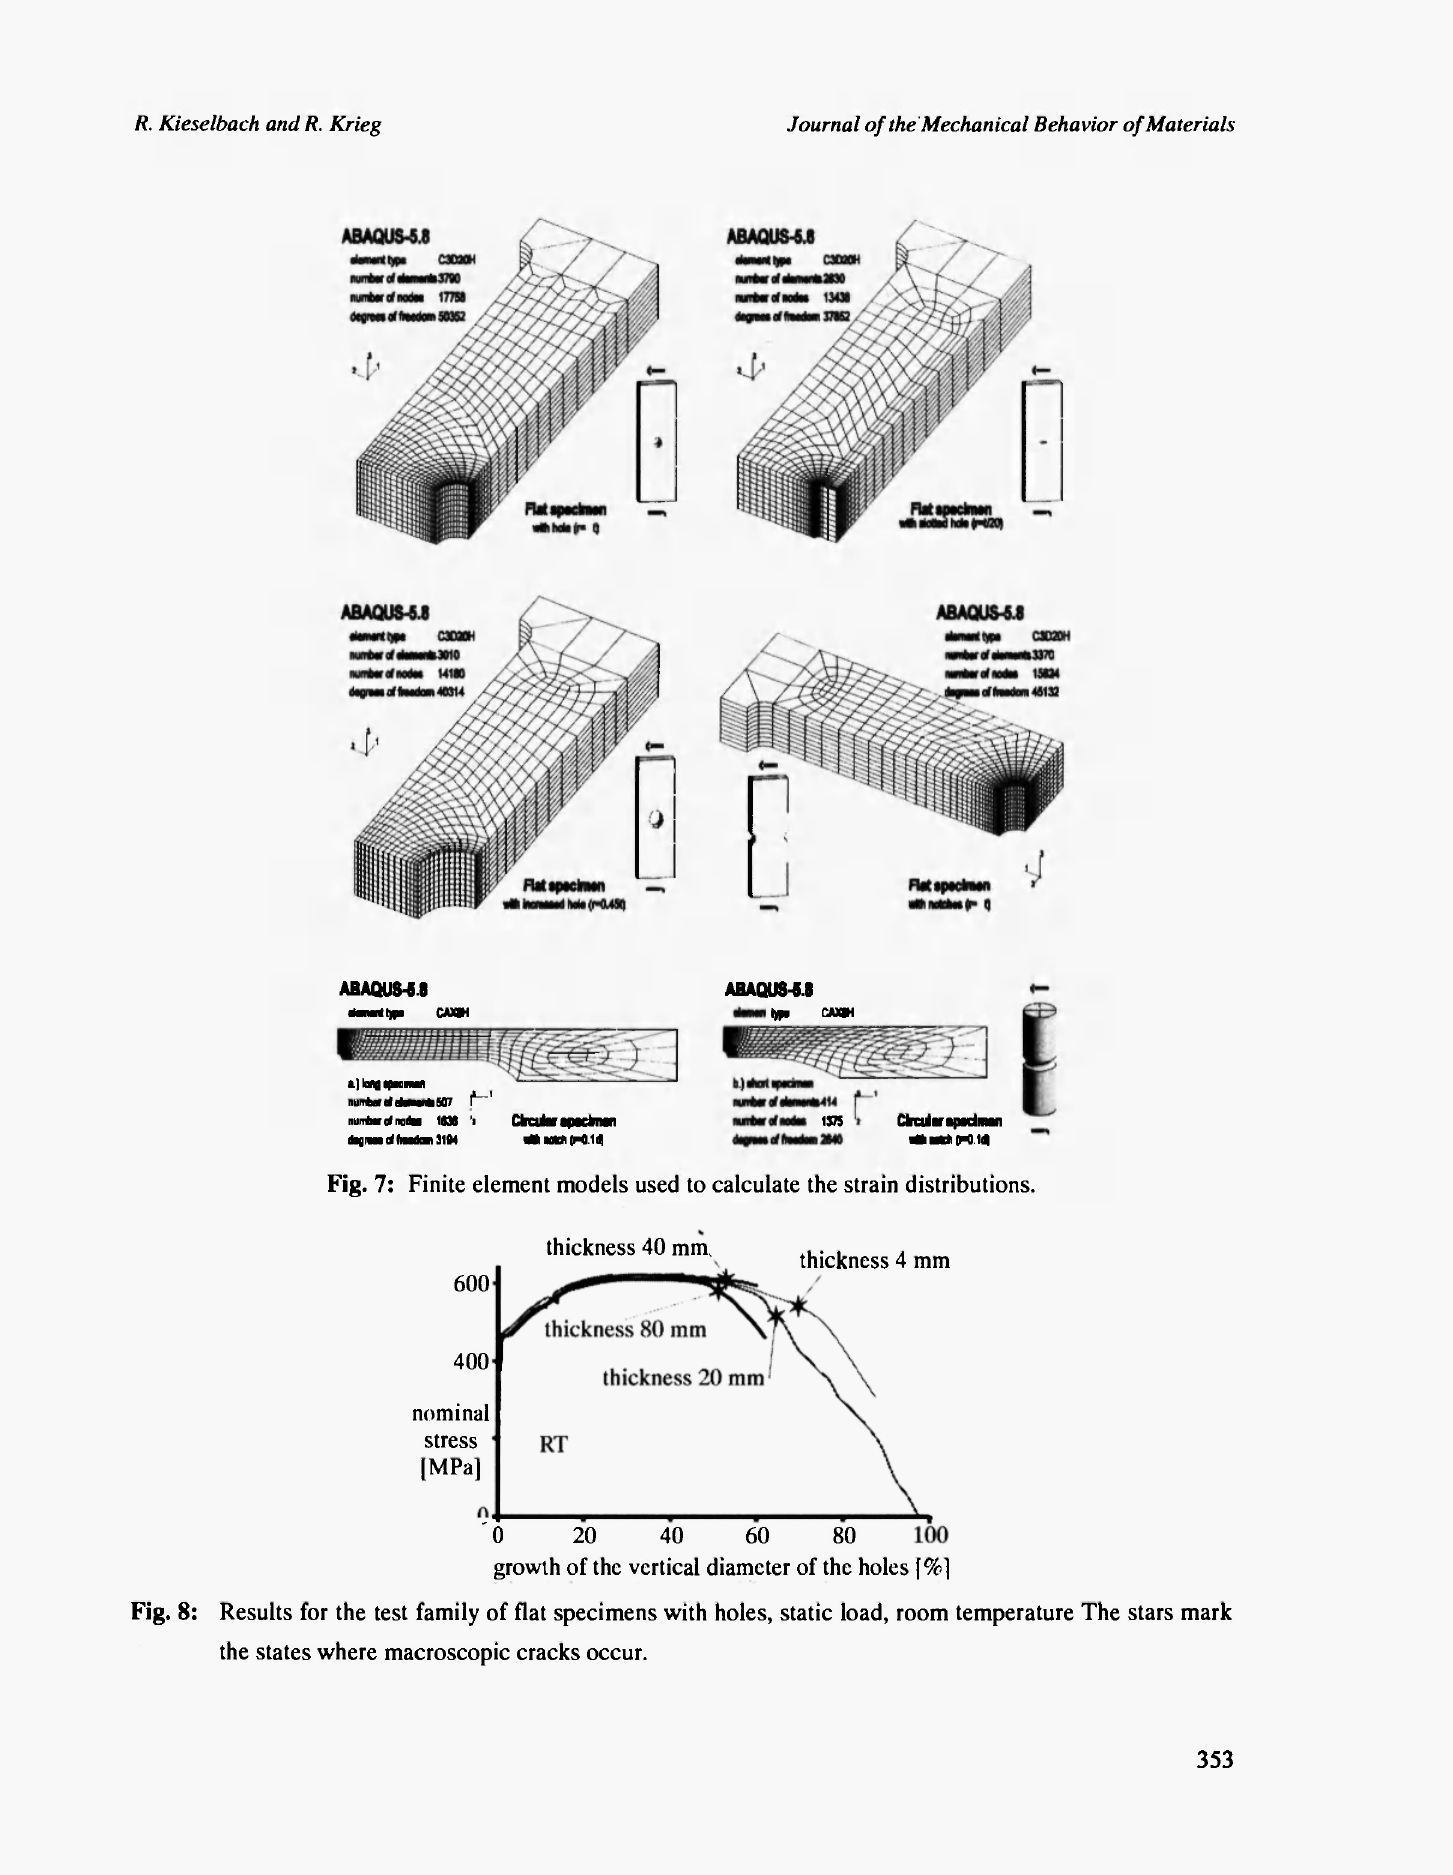
Fig. 8: Results for the test family of flat specimens with holes, static load, room temperature The stars mark the states where macroscopic cracks